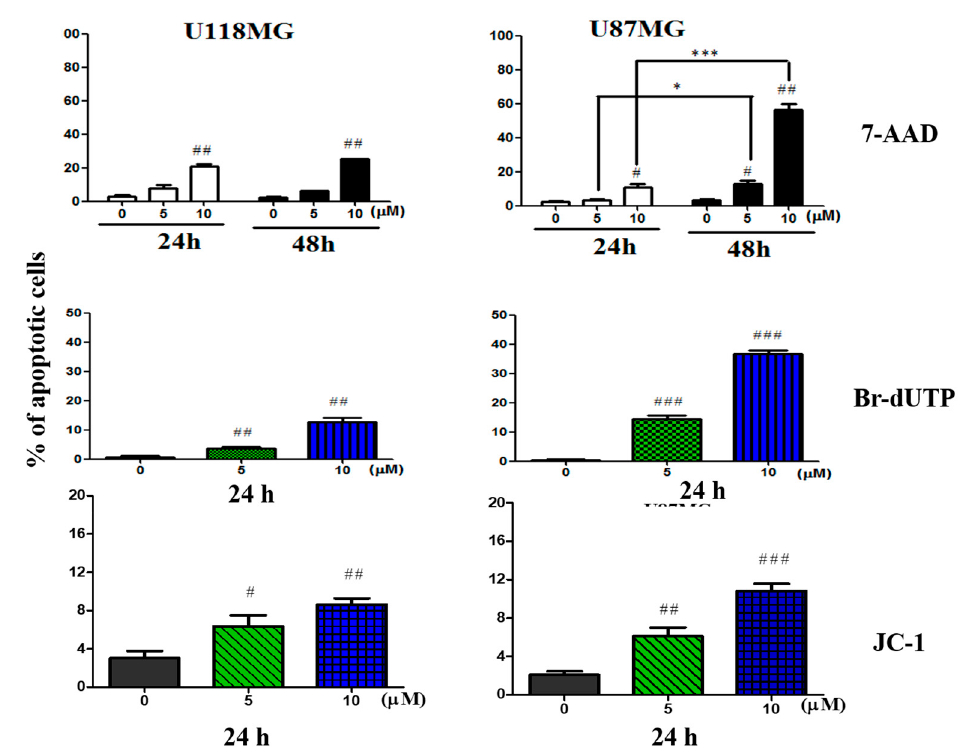
Figure 4. CC12 treatment increased the apoptosis rate and DNA damage. Results of 7-AAD, Br-dUTP, and JC-1 staining all indicated that the apoptotic cells were more after GBM cells were treated by CC12. # and ## indicates significant difference compared with the control group, p < 0.05 and <0.01, respectively; * and *** indicates significant difference between 24 h and 48 h treatments within the same concentration groups, p < 0.05 and <0.01, respectively.